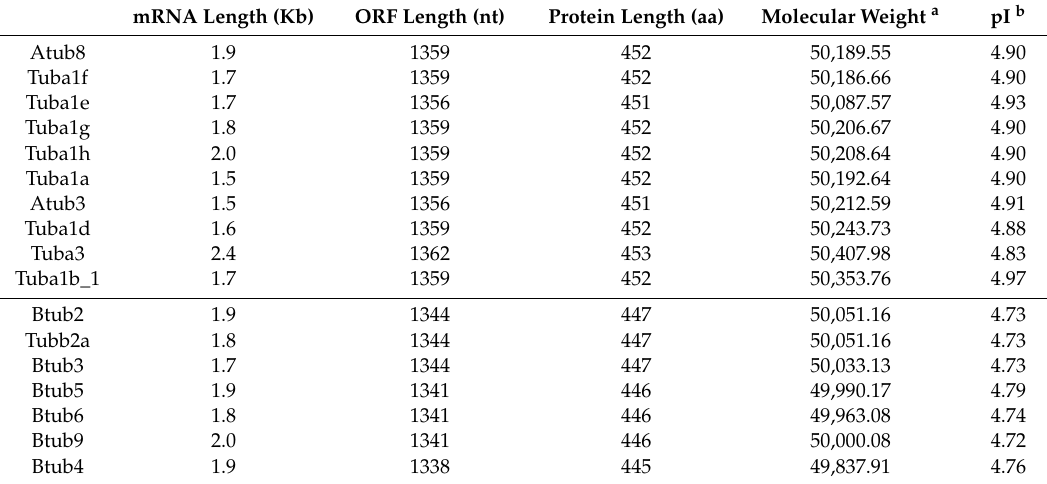
Table 1. The P. lividus α - and β